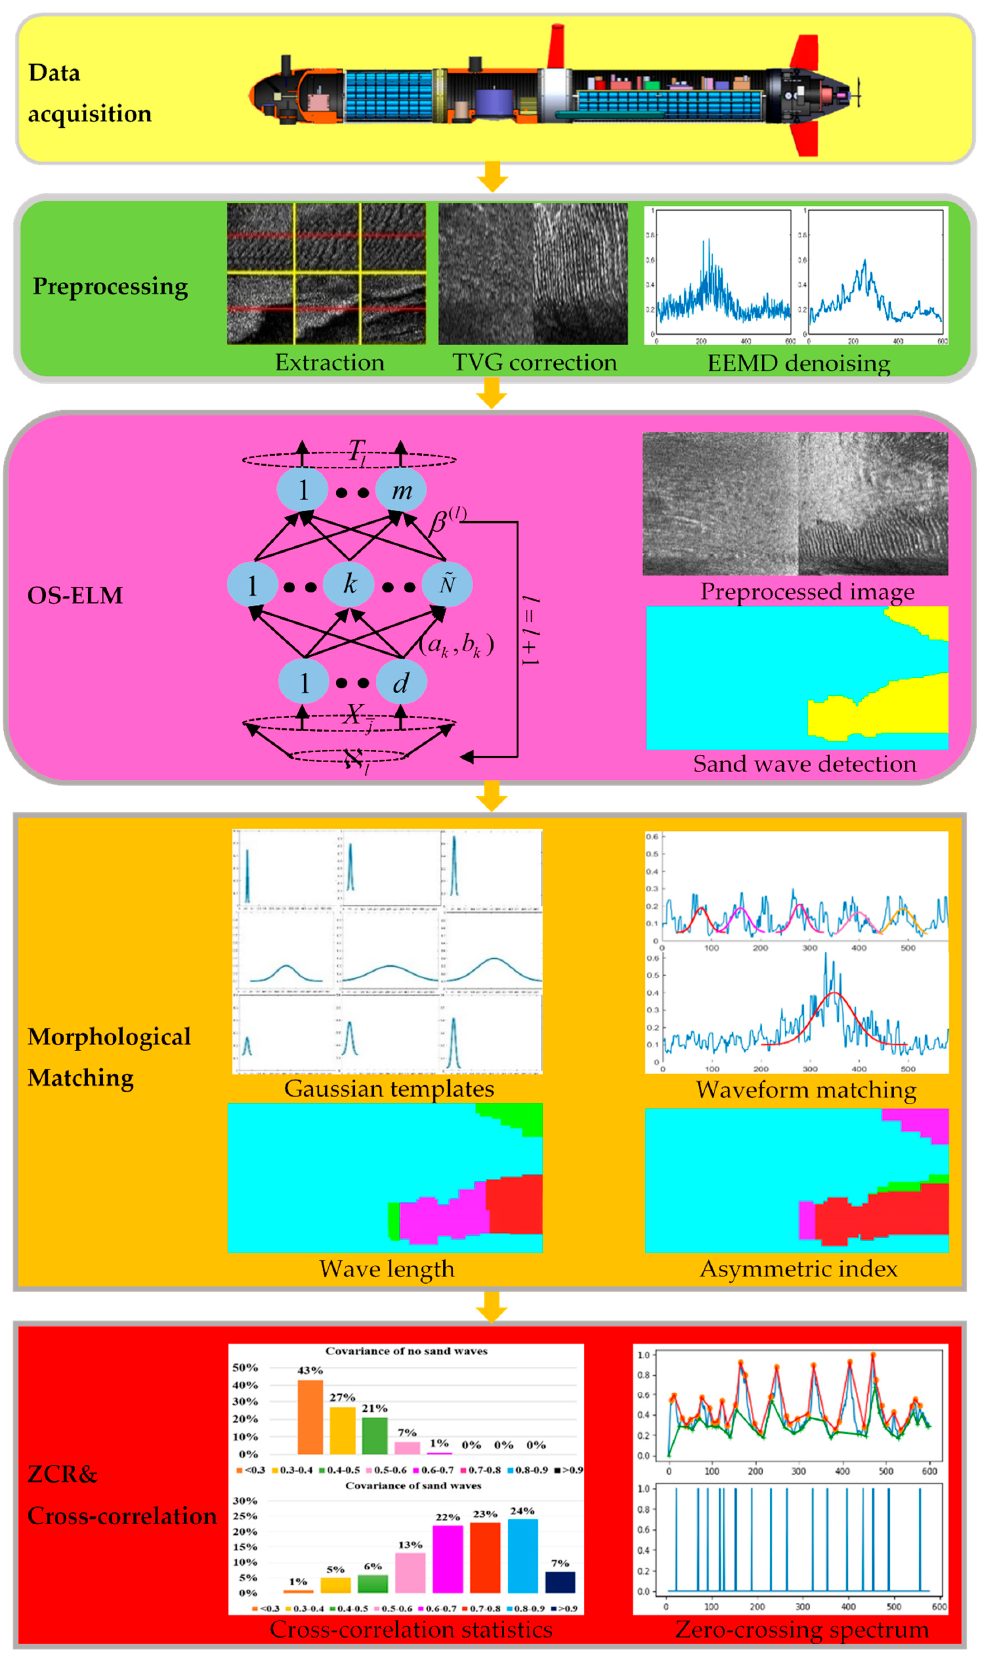
Figure 2. The flow chart of the proposed